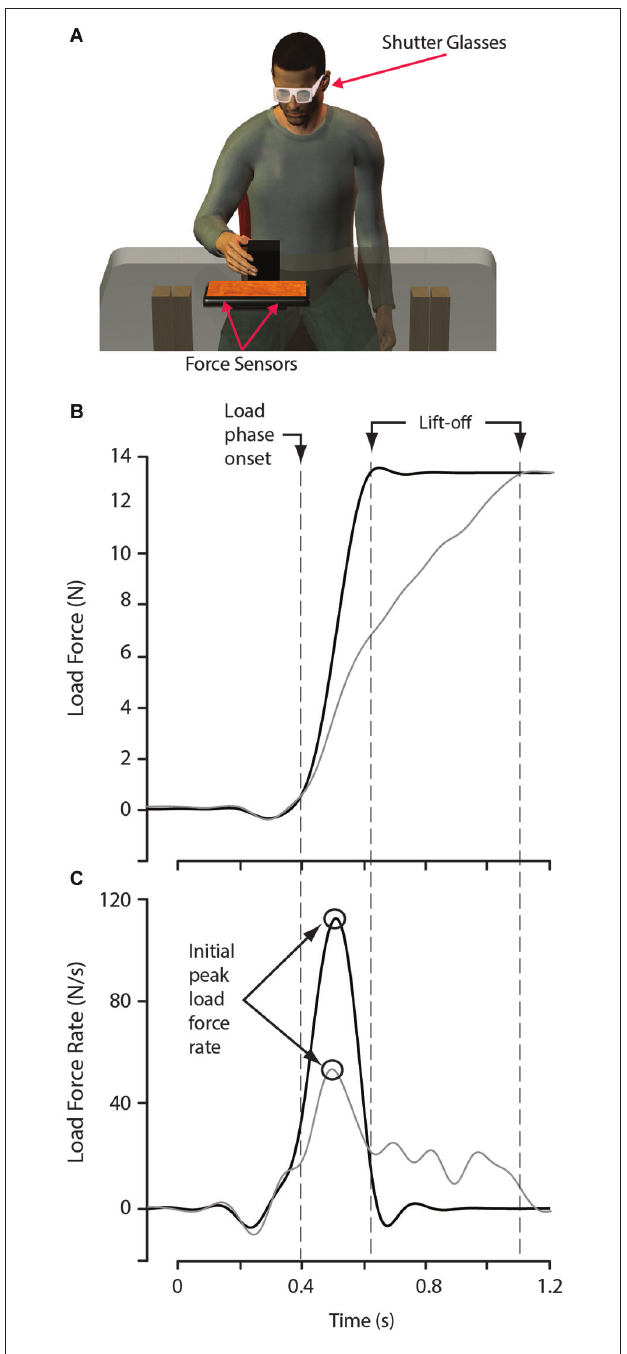
FIGURE 1 | Experimental apparatus and data analysis. (A) While seated, participants lifted and replaced an object located on top of a platform instrumented with two force sensors. Shutter glasses were opaque between trials, preventing the participant from observing the to-be-lifted block being placed. (B) Load force function from two lifts of the large red object, in one lift (gray curves) the initial increase in load force was too low for the object weight, in the other lift (black curves), the initial increase in load force accurately reached the object weight. (C) Corresponding load force rate functions. Of importance, the initial peak in load force rate scaled with the initial increase in load force, which is dependent on predicted object